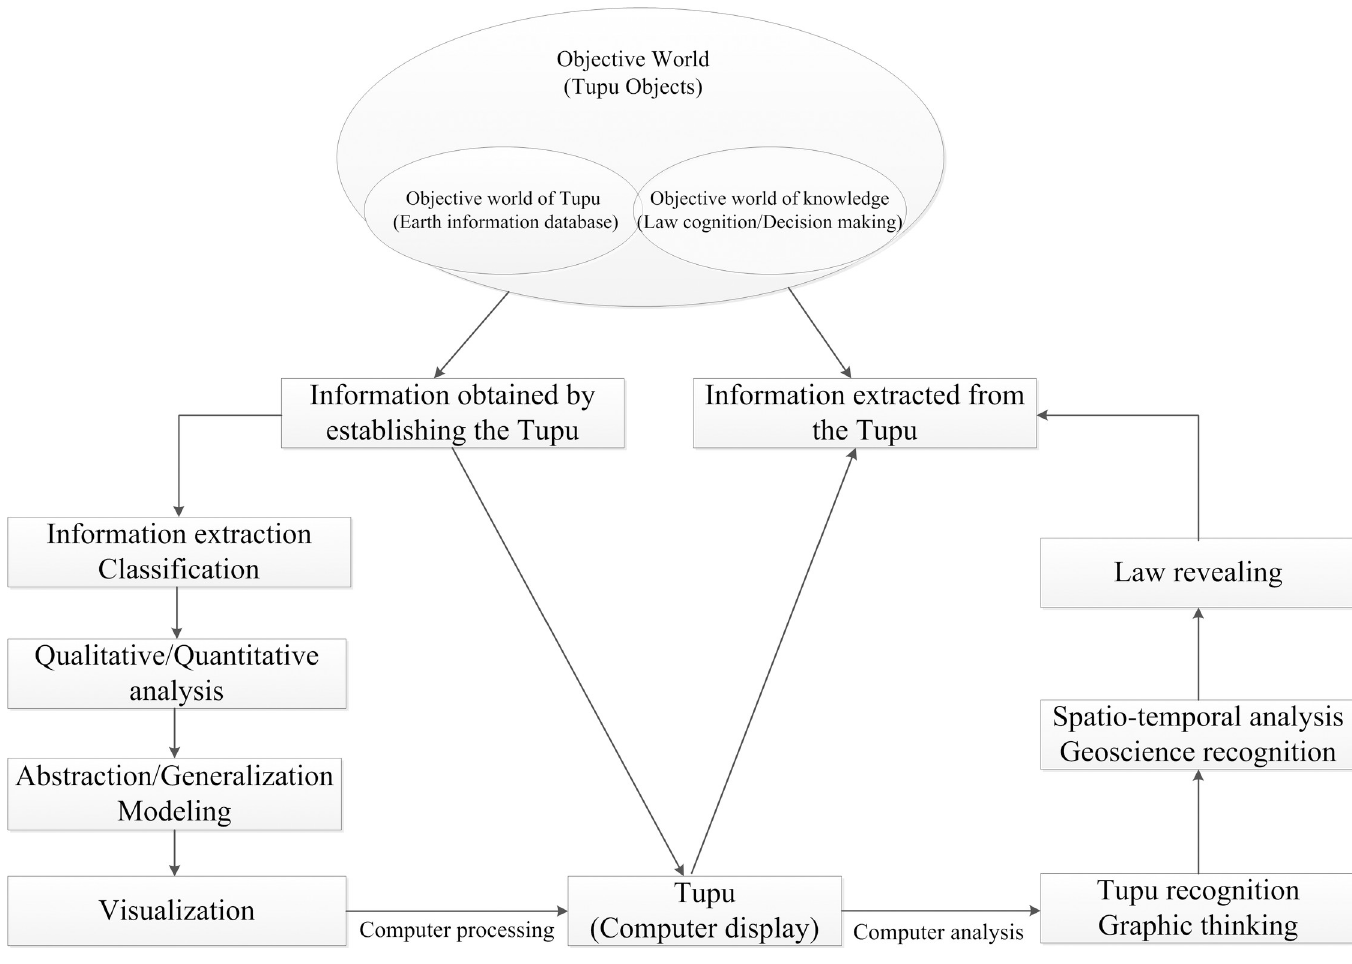
Fig 3. Generation and transmission mode of Geo-Informatic